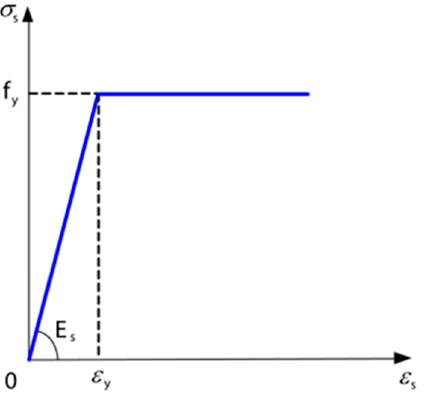
Figure 18. Constitutive relationship between the steel and structural reinforcement.